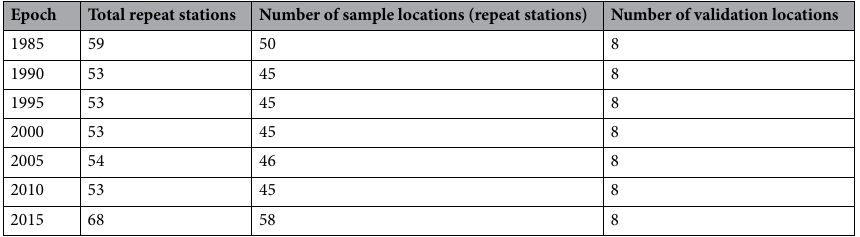
Table 1. The number of sample and validation data sets used in each epoch